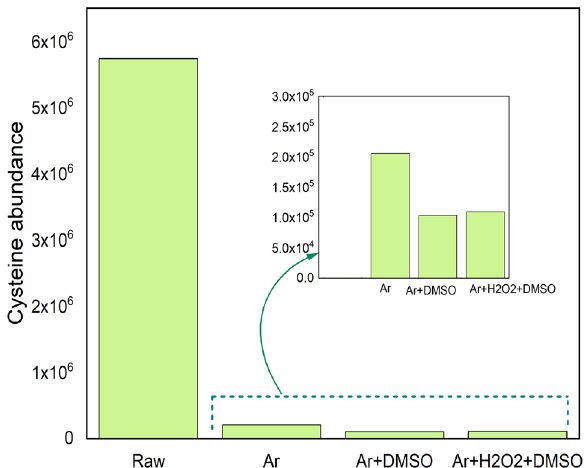
Figure 5. Comparison of the abundance of cysteine in the untreated sample with the other three plasmas with Ar as feeding gas.